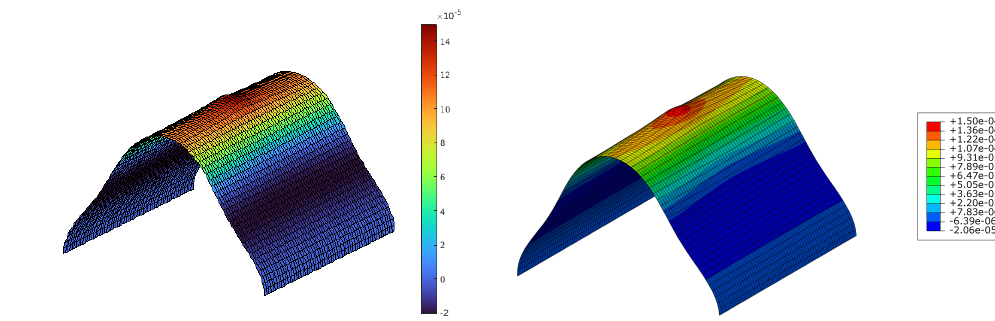
Figure 5. Deformation of the structure obtained with Matlab ( left ) and Abaqus ( right